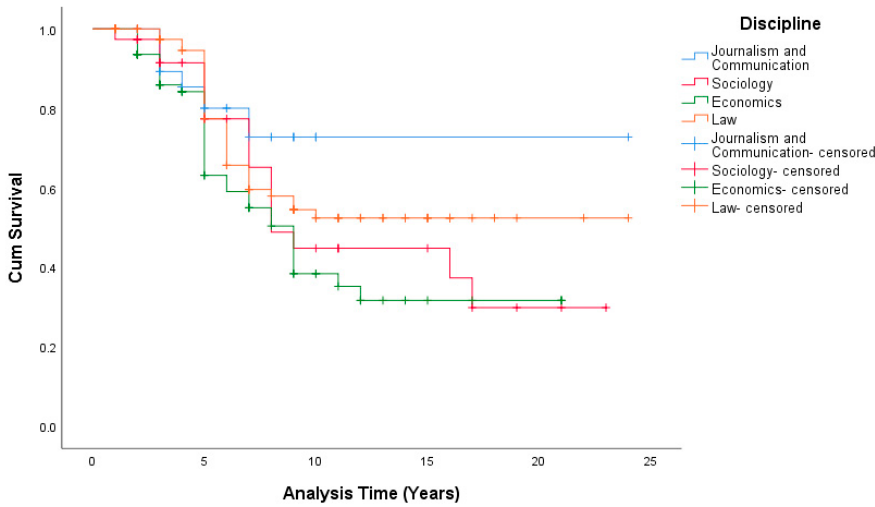
Figure 4. Survival Functions From Associate to Full Professor (Disciplines).